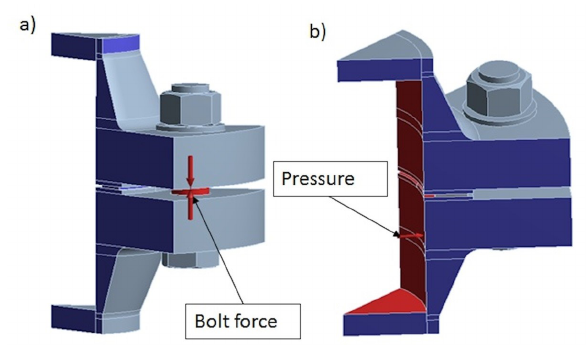
Figure 8: The geometrical model as well as boundary conditions of